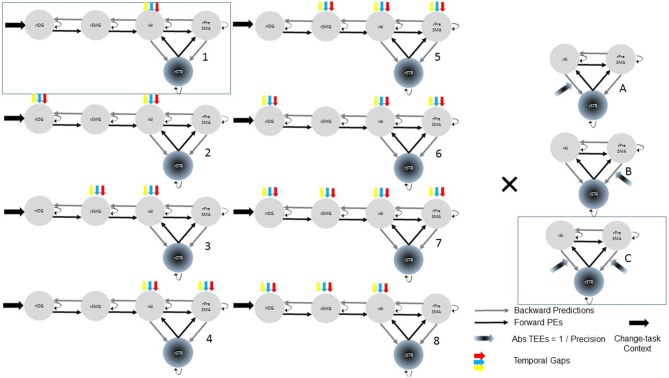
Model space with 24 (8 × 3) possible models representing our hypotheses. In all models, all the trials of the change-task condition entered the rIOG and temporal gaps drove activity at least into the rAI. TEEs modulated at least one corticostriatal connection. Combinations of driving inputs are represented with numbers (1–8). Combinations of modulatory inputs are represented with letters (A–C). Each single model is represented by one number and one letter (e.g., A3). Bayesian model selection provided support to the model 1C (within the rectangle).